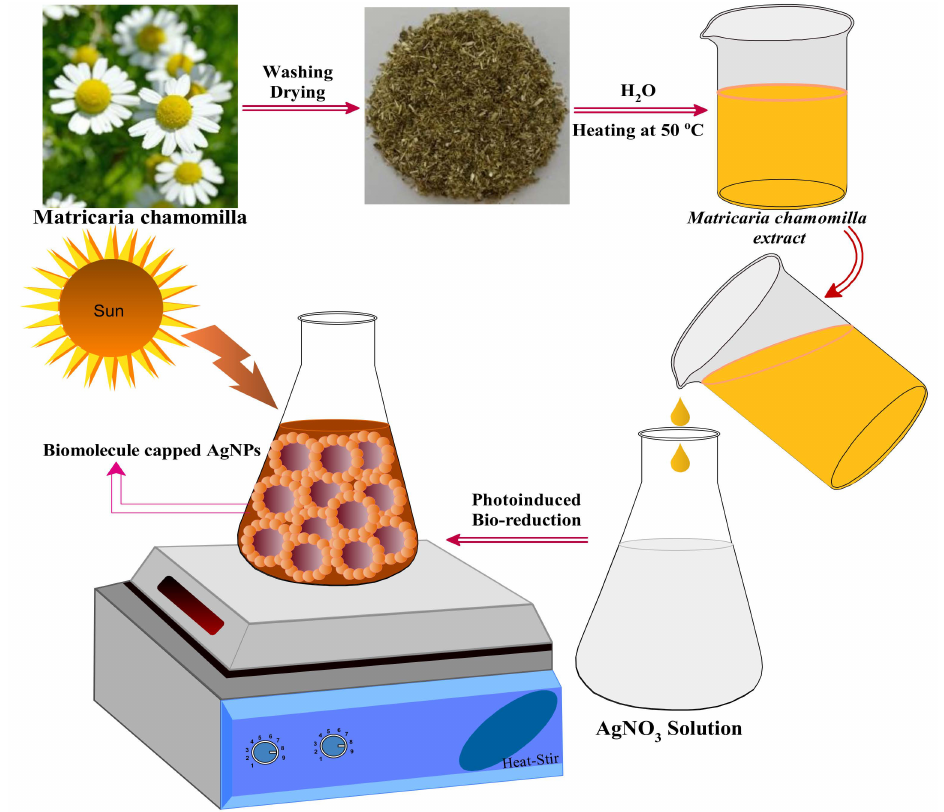
Figure 4. Biomolecule-assisted synthesis of capped AgNPs upon the photo-induced chemical reduction synthetic